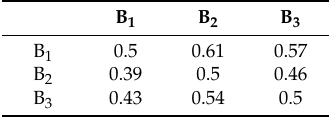
Table 4. The judgment matrix.